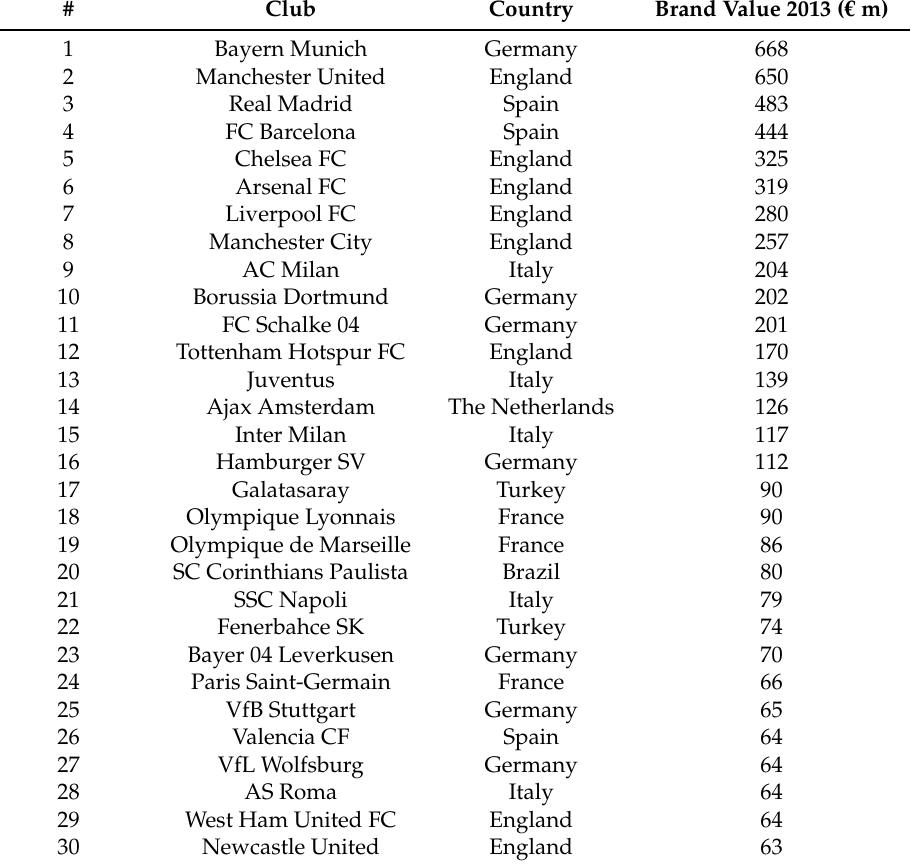
Table 4. Top 30 global football clubs by brand value in